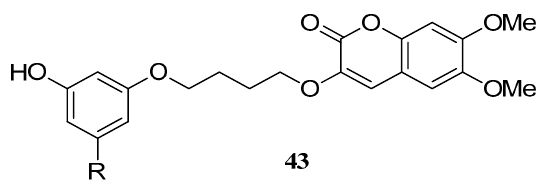
Figure 5. Structure of 6,7-dimethoxy-3-substituted coumarin.